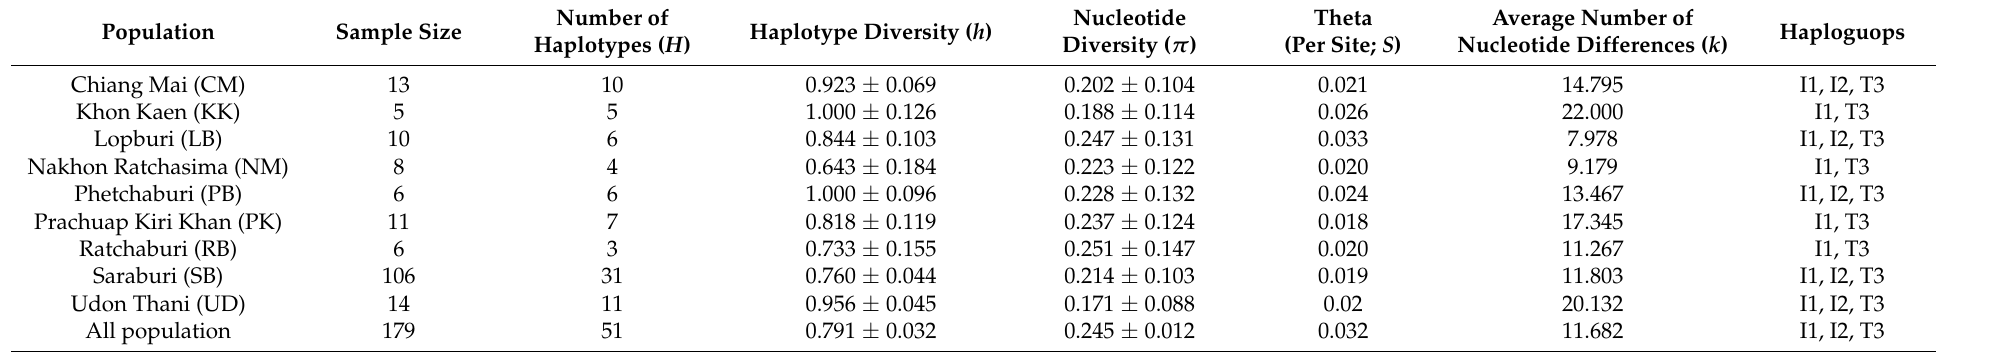
Table 2. Mitochondrial D-loop sequence diversity for cattle in all sampled populations of